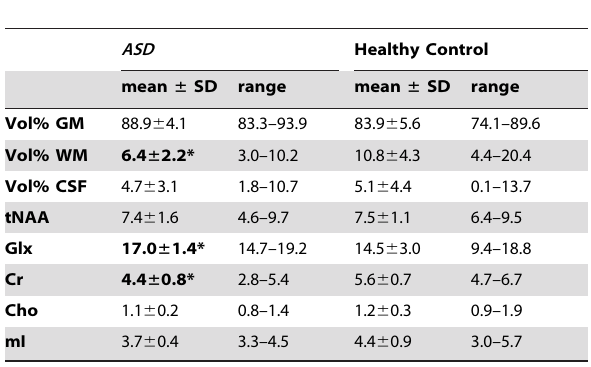
Table 2. Experiment 1: Voxel tissue content and proton magnetic resonance spectroscopy ( 1 H MRS) metabolite levels in midline pregenual anterior cingulate cortex (pACC)